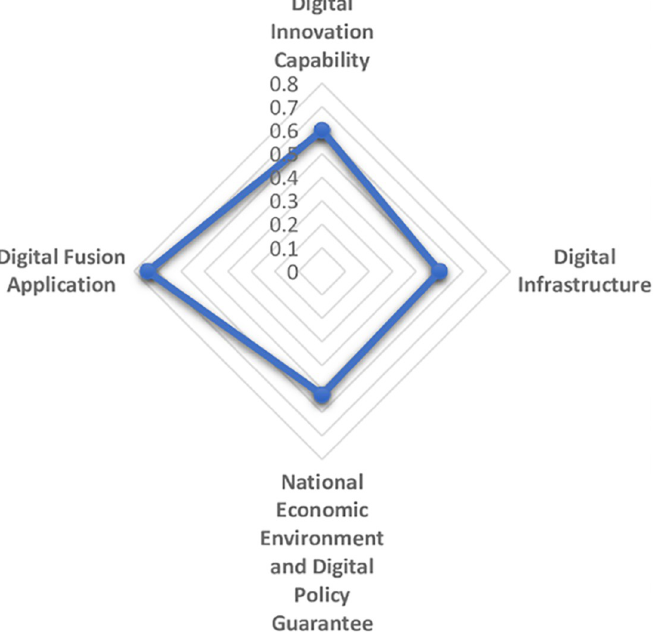
Fig 7. Radar map of digital economy development in central